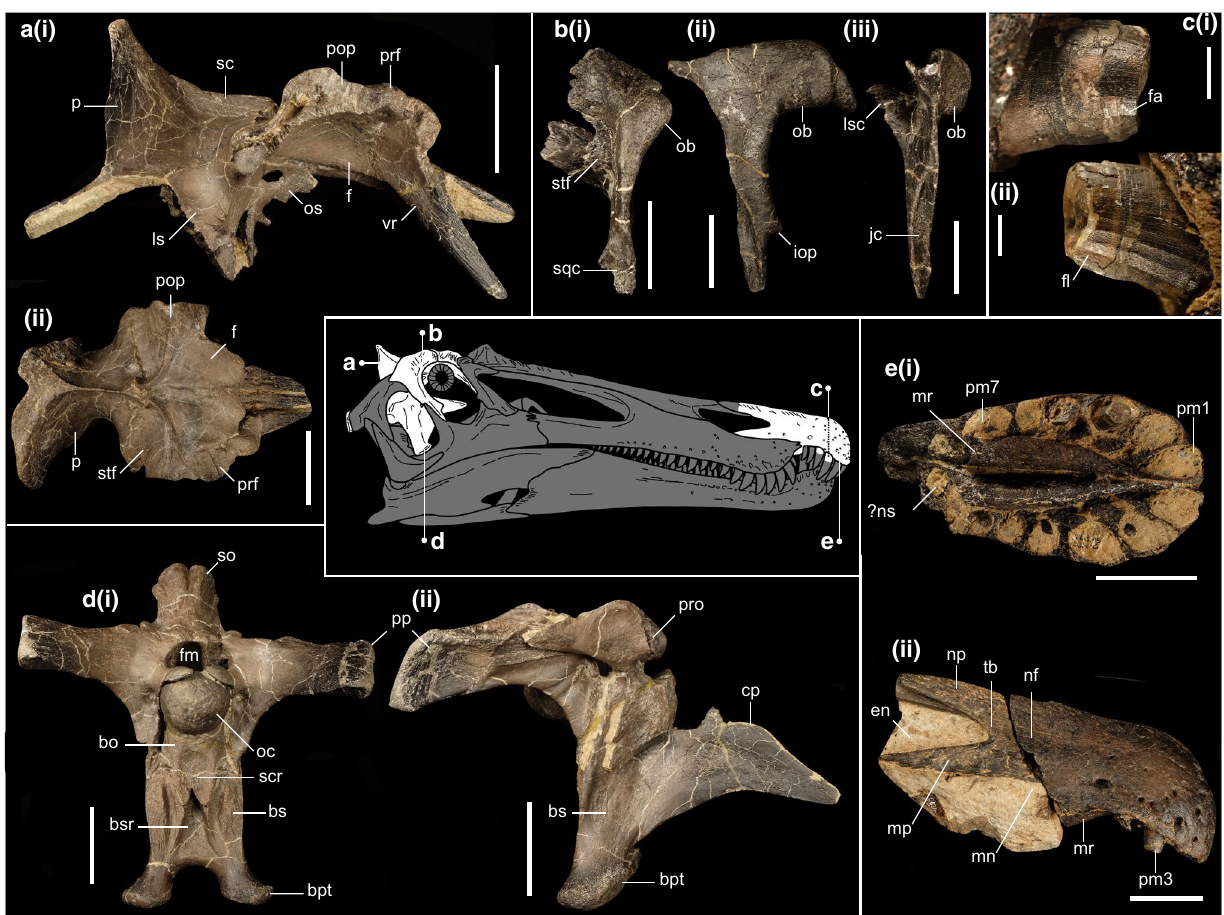
Figure 3. Cranial material of Ceratosuchops inferodios . ( a ) Holotype skull roof fragment (IWCMS 2014.95.1), in (i) right lateral and (ii) dorsal views; ( b ) referred right postorbital (IWCMS 2014.95.4), in (i) dorsal, (ii) lateral and (iii) posterior views; ( c ) close up of holotype in situ Rpm3 (IWCMS 2014.95.5) in (i) labial and (ii) lingual views; ( d ) holotype basicranium (IWCMS 2014.95.3), in (i) posterior (rearticulated with the supraoccipital + left otoccipital fragment IWCMS 2014.95.2) and (ii) right lateral views; ( e ) holotype premaxillae (IWCMS 2014.95.5, 2021.30), in (i) ventral and (ii) right lateral views. bo basioccipital, bs basisphenoid, bpt basipterygoid process, bsr basisphenoid recess, cp cultriform process, en external naris, f frontal, fa faceting, fl fluting, fm foramen magnum, iop infraorbital process, jc jugal contact, ls laterosphenoid, lsc laterosphenoid contact, mn maxillary notch, mp maxillary process, mr median ridge, nf narial fossa, np nasal process, ns nasal sinus, ob orbital boss, oc occipital condyle, os orbitosphenoid, p parietal, pop postorbital process, pm(n) premaxillary tooth/alveolus (tooth position), prf prefrontal, pro prootic, sc sagittal crest, scr subcondylar recess, so supraoccipital, sqf squamosal contact, stf supratemporal fossa, tb tuberosity, vp ventral process of the prefrontal. Skull reconstruction credit: Dan Folkes (CC-BY 4.0). Scale bars a–b, d–e: 50 mm; c: 5